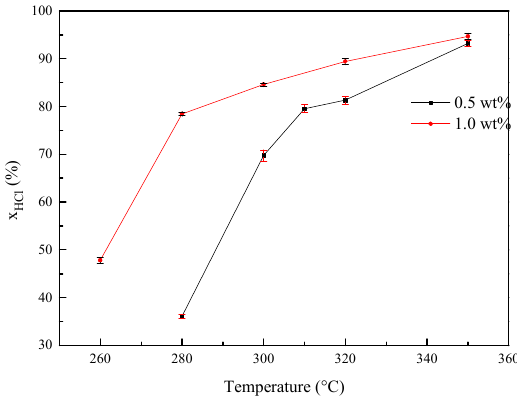
Figure 9. The influence of Ru loading at 350 °C ( a ) and feed O 2 /HCl ratio at 320 °C ( b ) on HCl conversion. Note volumetric flowrate HCl/O 2 = 1:2 for ( a ).